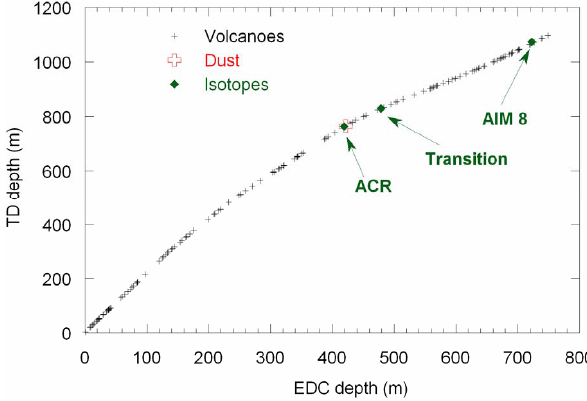
Fig. 6. Depth-to-depth relationship of the common volcanic events detected in the two ice cores and pairs of synchronous events identified using other parameters (isotopes and dust).